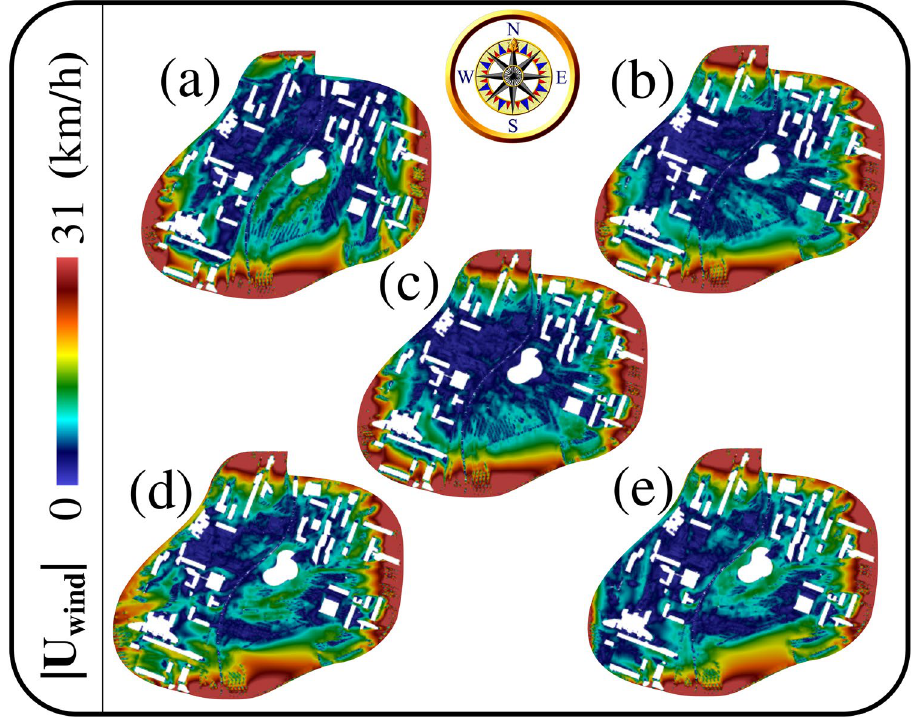
Figure 2. Local wind speed magnitude maps computed at t = 6 min. In the centre, one can see the Library of the University of Lille and the Lilliad Learning Center Innovation 28 . Both are frequently visited by scientists and students from and outside the campus. CFD results at z = 5 m above the ground level z = 0 ; computational results for the 5 days: ( a ) 06/04/2020; ( b ) 07/04/2020; ( c ) 08/04/2020; ( d ) 09/04/2020; ( e )